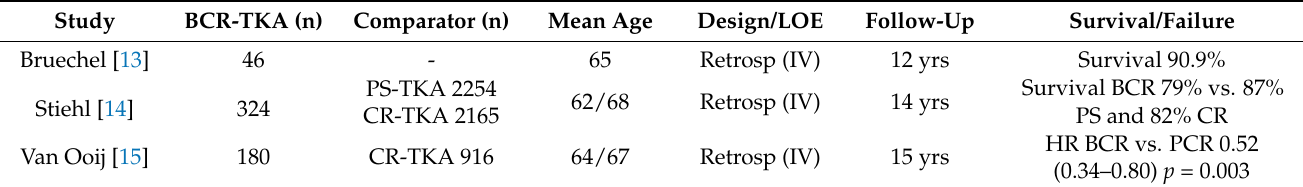
Table 1. Clinical outcome studies for LCS